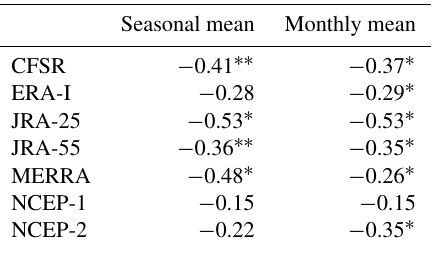
Table 3. Correlation of longitudinal and latitudinal location of the SAH centre based on seasonal mean (JJA mean) and monthly mean (deseasonalised) data from June to August 1979–2014 (1979–2010 for CFSR and 1979–2013 for JRA-25). Asterisks indicate the sig- nificance levels of the correlation